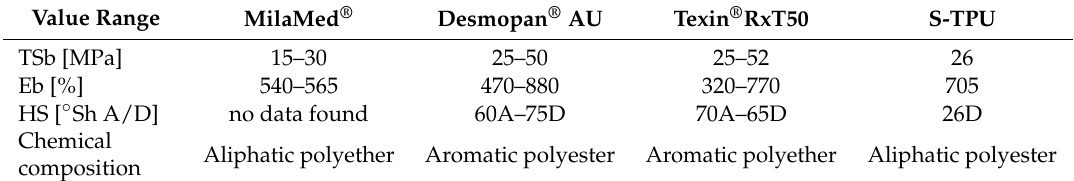
Table 4. Comparison of available medical-grade polyurethanes properties with the synthesized uncatalyzed S-TPU system. (The data were taken from the material safety data sheets available on the manufacturers’ websites).